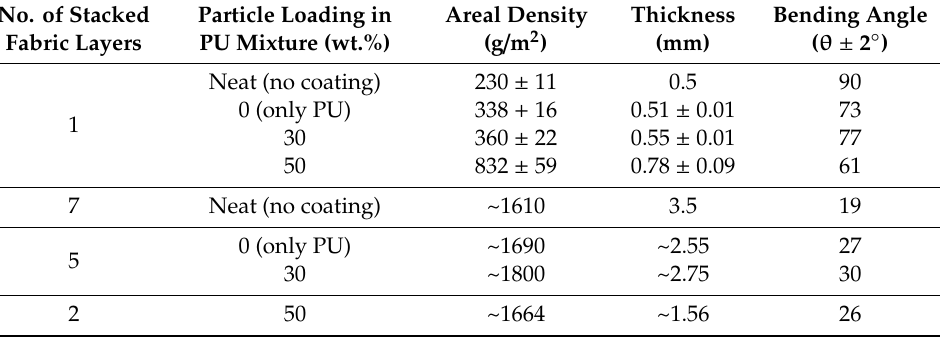
Table 1. Areal density, thickness, and bending angle of plasma-treated neat and coated UHMWEPE fabric